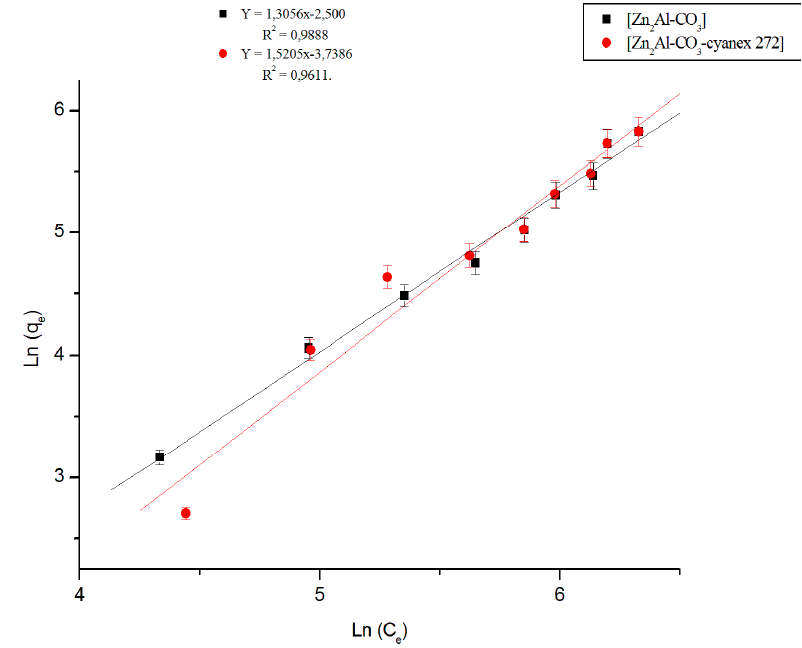
Figure 11. Freundlich isotherm of Zn(II) extraction.